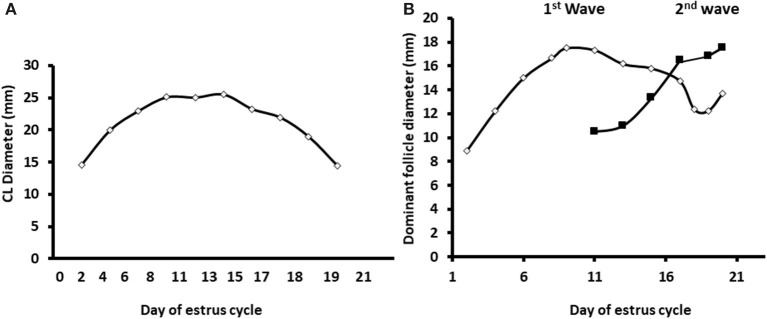
Diameter of the developing corpus luteum and the dominant follicles through the estrous cycle. The data displayed as the average diameters measured in dairy cows along the estrous cycle (n = 12) of the corpus luteum and largest follicle in the two follicular surges during a normal estrous cycle. (A) Daily average diameter of the corpus luteum (CL) along the estrous cycle. (B) Average diameter of the dominant follicles during two subsequent follicular surges during the estrous cycle. Mean diameter of the largest follicle during the first and second follicular surge—white and black, respectively. Values represent mean ± SE.